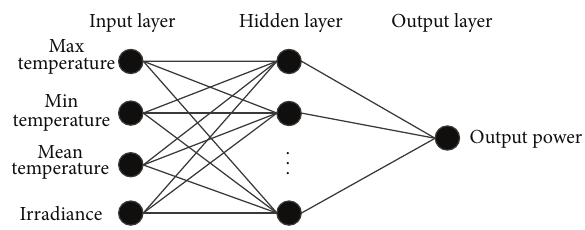
Figure 1: Diagram of prediction using